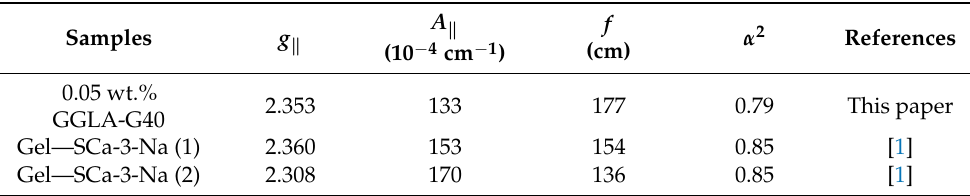
Table 8. The g (cid:107) factors and A (cid:107) values (in 10 − 4 cm − 1 ), the parameter f of the tetrahedral distortion and the covalency parameter α 2 for the studied 0.05 wt.% GGLA-G40 sample.